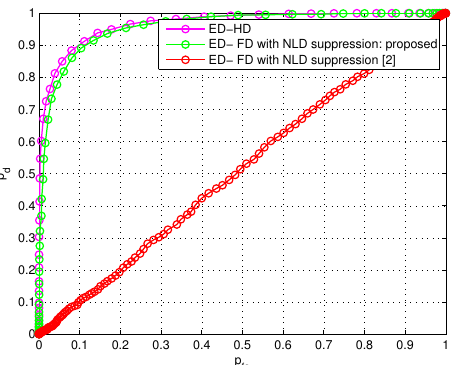
Figure 5. The power of ˆ Y ( m ) under H (1) our proposed method, (2) the method of [2] is applied and (3) under HD mode